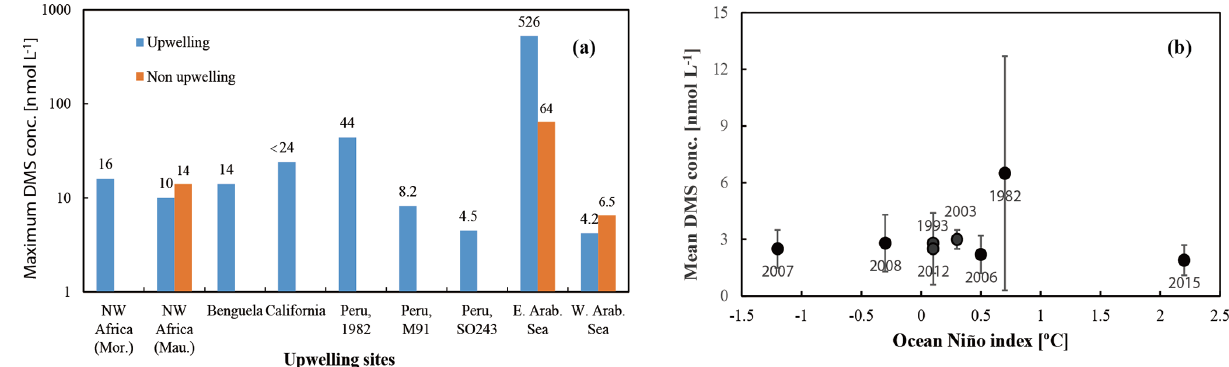
Figure 5. (a) Maximum DMS concentrations measured in various upwelling regions worldwide. Mor. stands for Morocco, and Mau. stands for Mauritania. (b) Mean and standard deviation of DMS concentrations for each cruise in the ETSP. Note that the value from 2003 only includes the data east of 95 ◦ W.